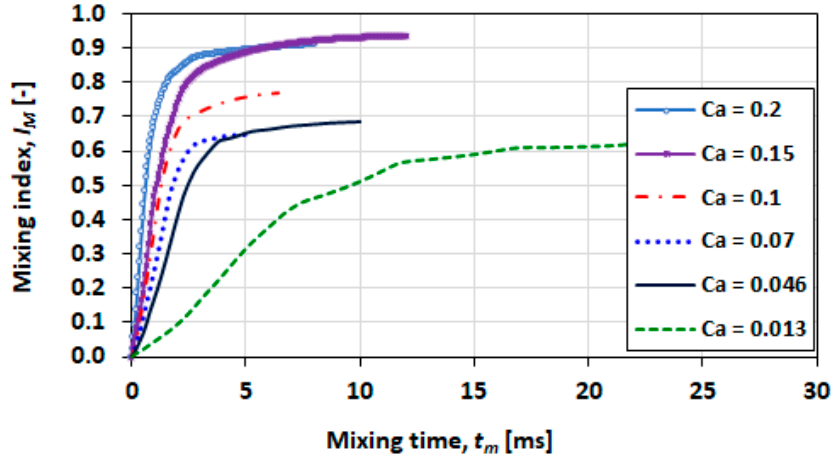
Figure 26. Mixing performance at various capillary numbers for 𝜆 = 0.1 .